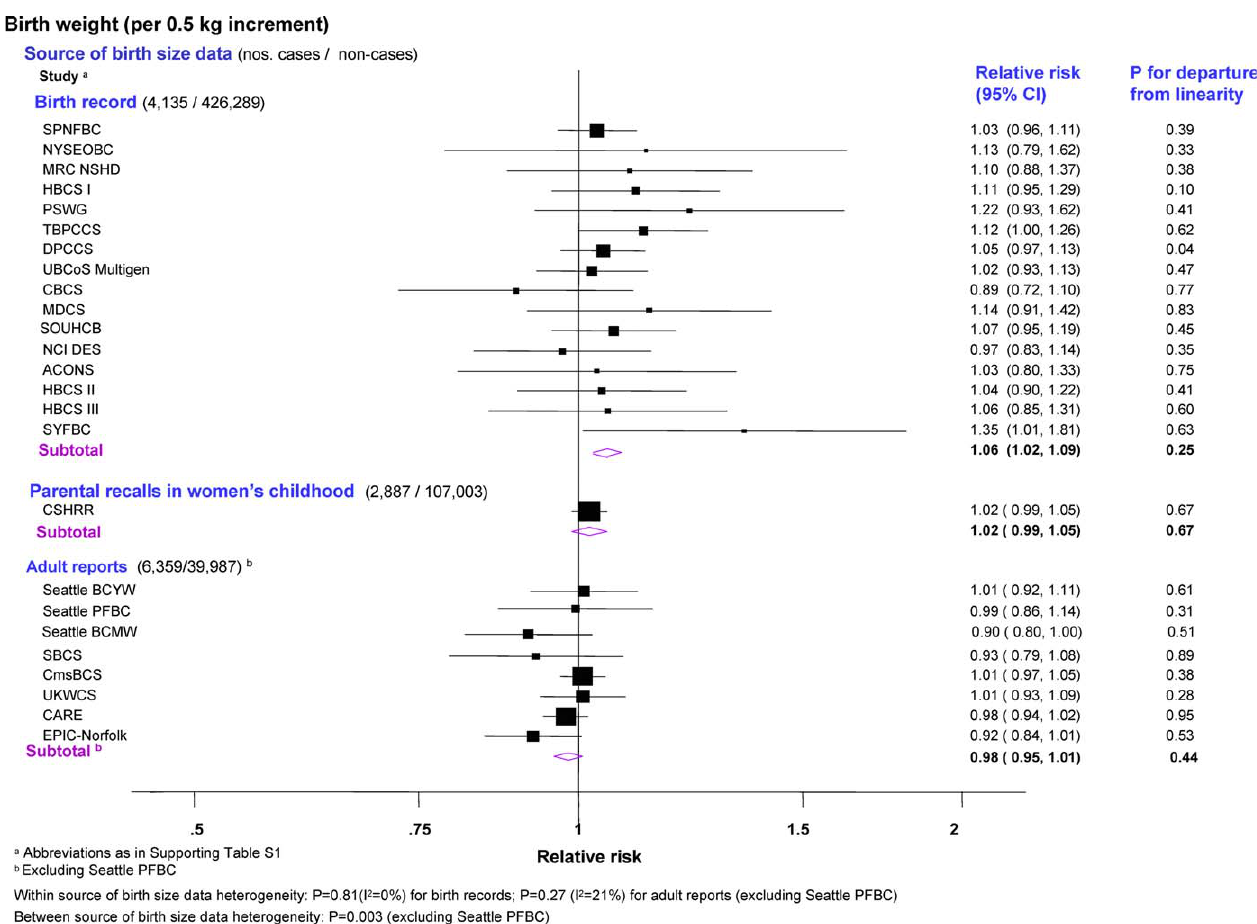
Figure 2. Minimally Adjusted Study-Specific and Pooled Breast Cancer RRs Stratified by Source of Birth Size Data in Relation to Continuous Birth Weight (Singleton Studies Only) The area of the black squares is inversely proportional to the variance (on the log scale).